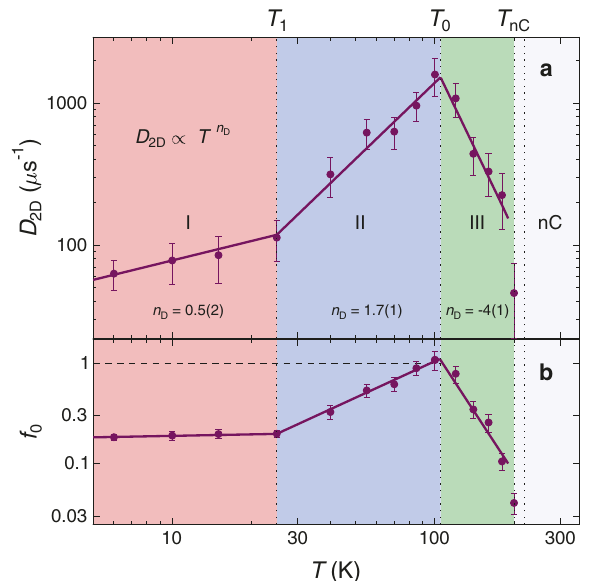
Fig. 3 Spinon diffusion obtained from LF- μ SR in the C-CDW region below T nC . a Temperature dependence of the 2D spinon diffusion rate D 2D . b The scaling parameter for the amplitude of the diffusive signal (taking Ā = 4.5 MHz). Three distinct regions are found in the measurements, labeled I, II, and III. In each case the error bars indicate standard errors of the fi t parameters.